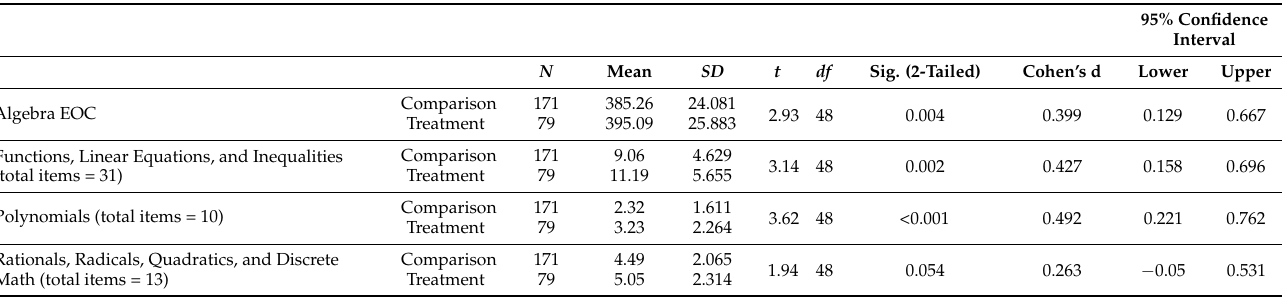
Table 1. School A: Algebra I EOC mean